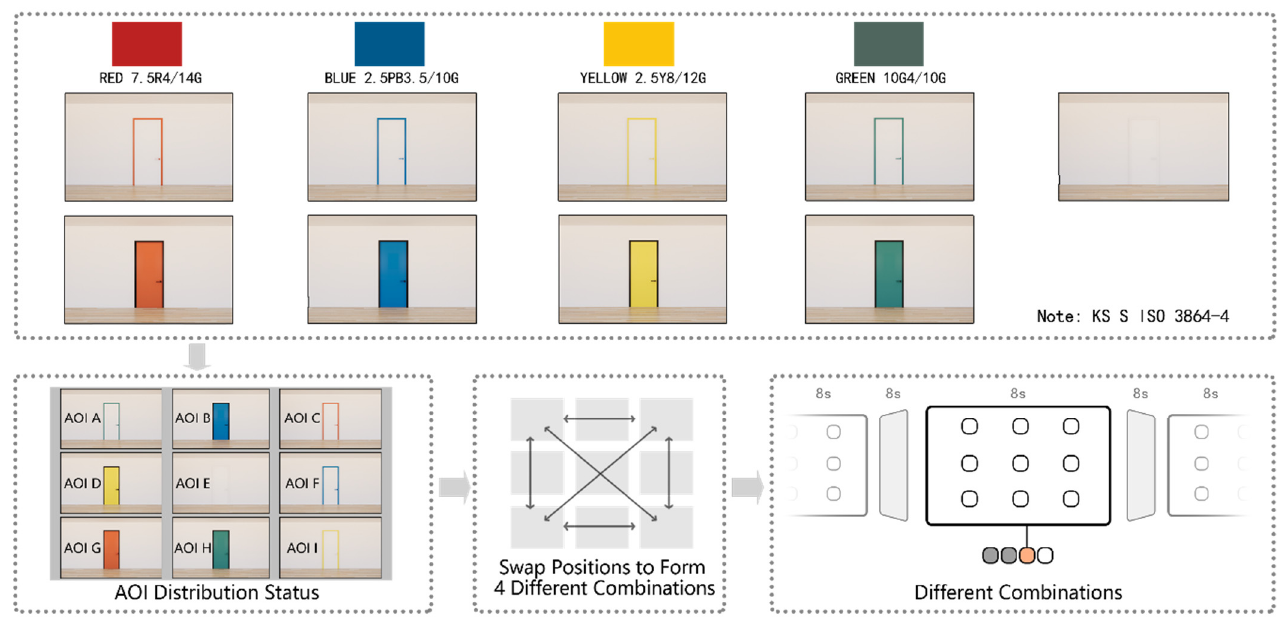
Figure 1. Stimuli and